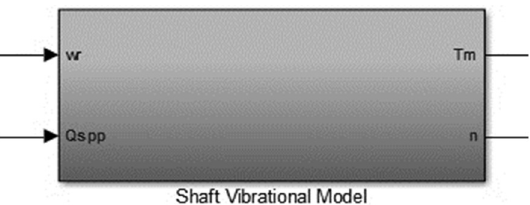
Figure 13. Inputs (left) and outputs (right) for the block. Implementing the shafting vibrational model in MATLAB/Simulink.